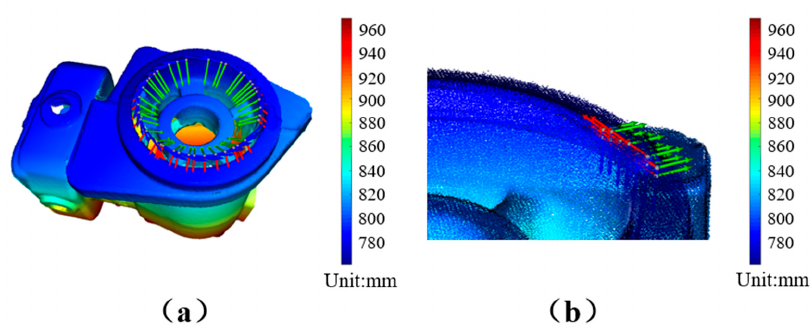
Figure 15. Grinding head position trajectory. ( a ) Pose trajectory diagram of the flash grinding tool. ( b ) Pouring riser grinding pose trajectory diagram.